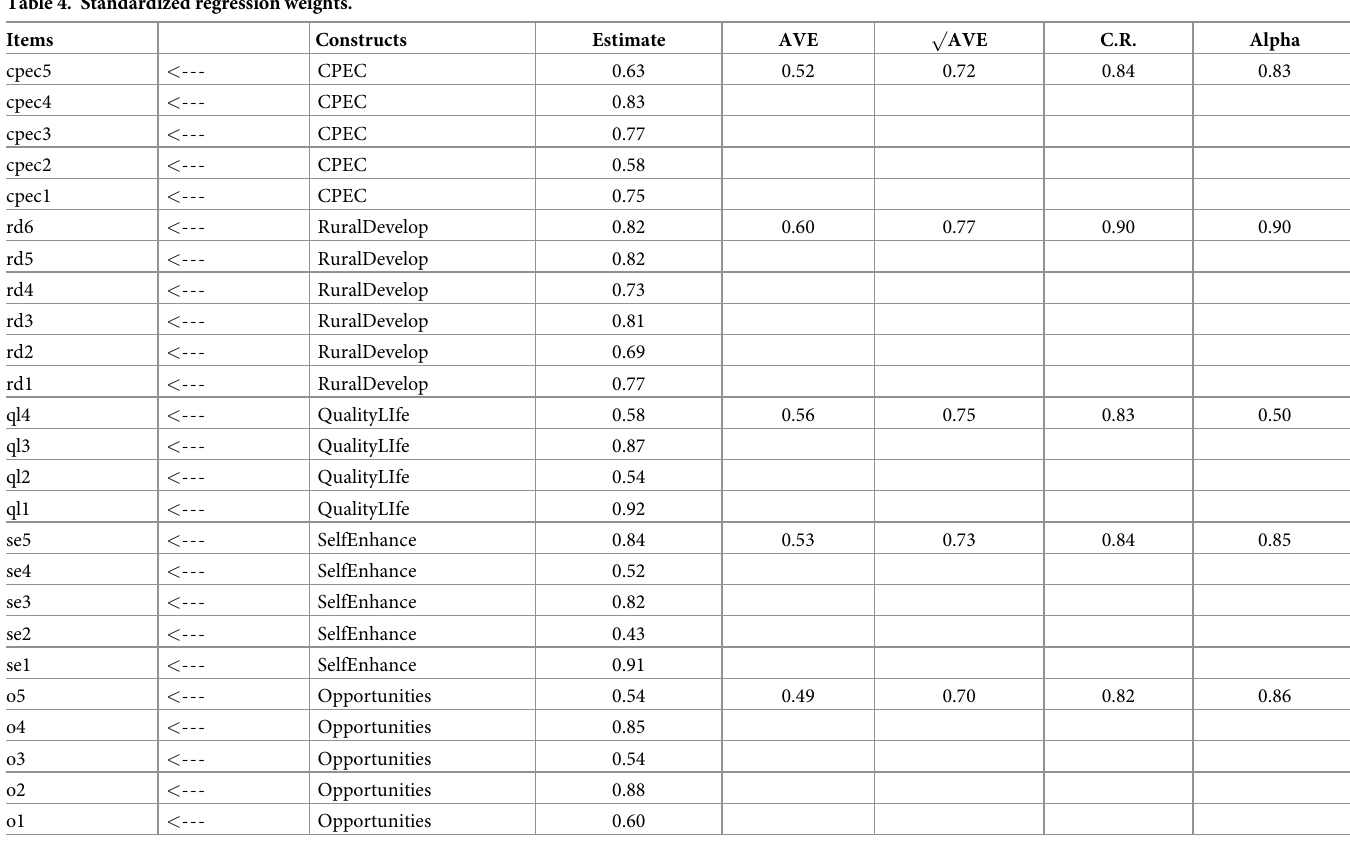
Table 4. Standardized regression